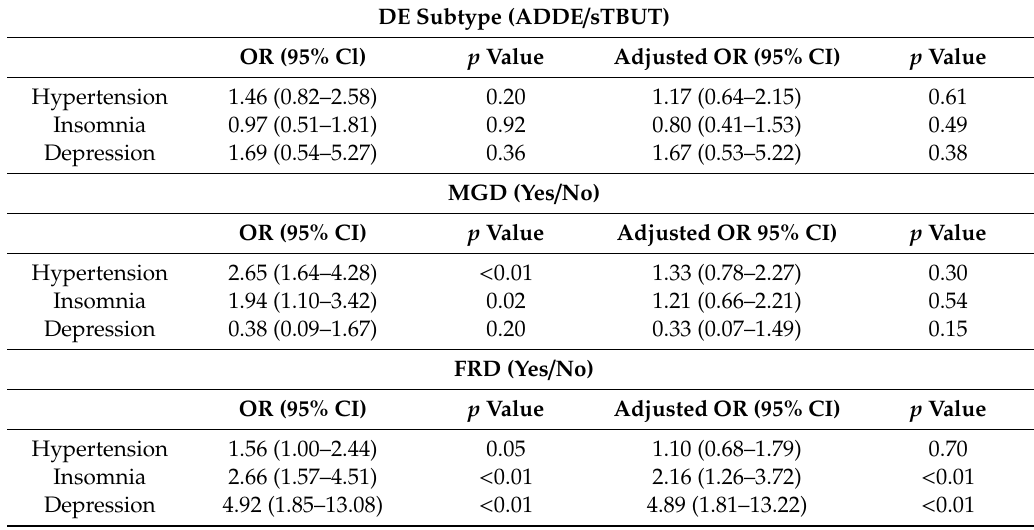
Table 5. Association between dry eye subtype and systemic